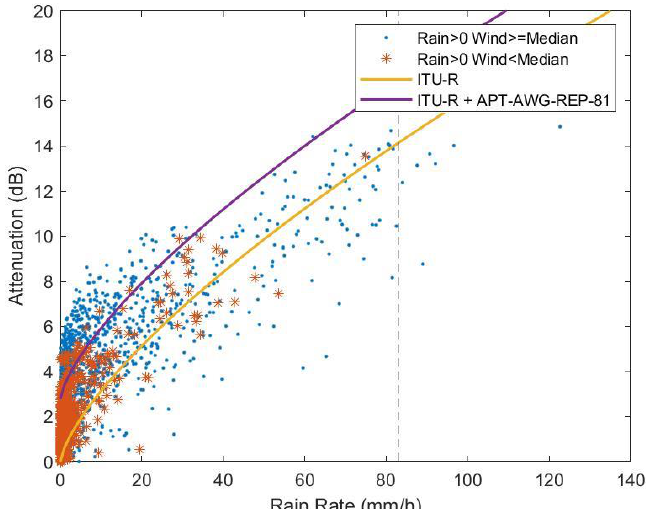
Figure 10. Average attenuation in 1-min intervals as a function of rain rate of two groups of data compared with ITU-R model and the combination of ITU-R and APT-AWG-REP-81